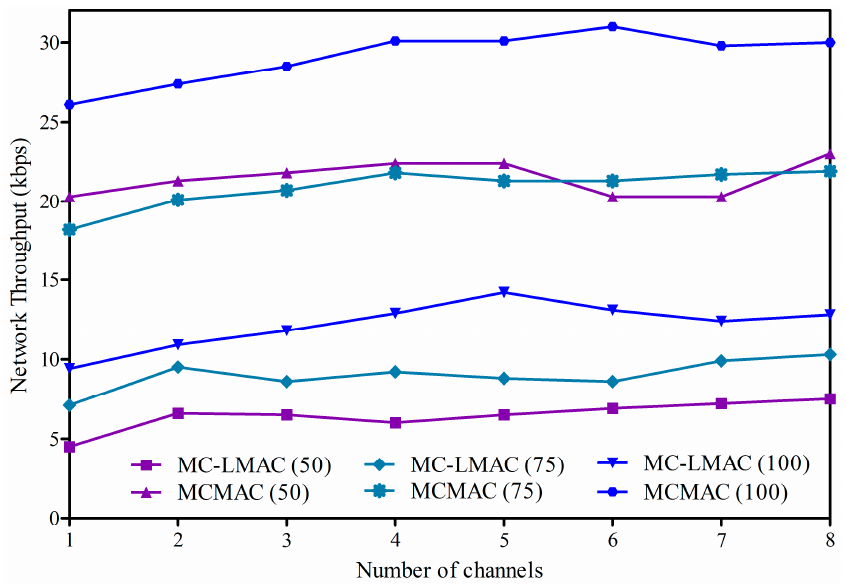
Figure 11. Network throughput according to the number of channels and network density.